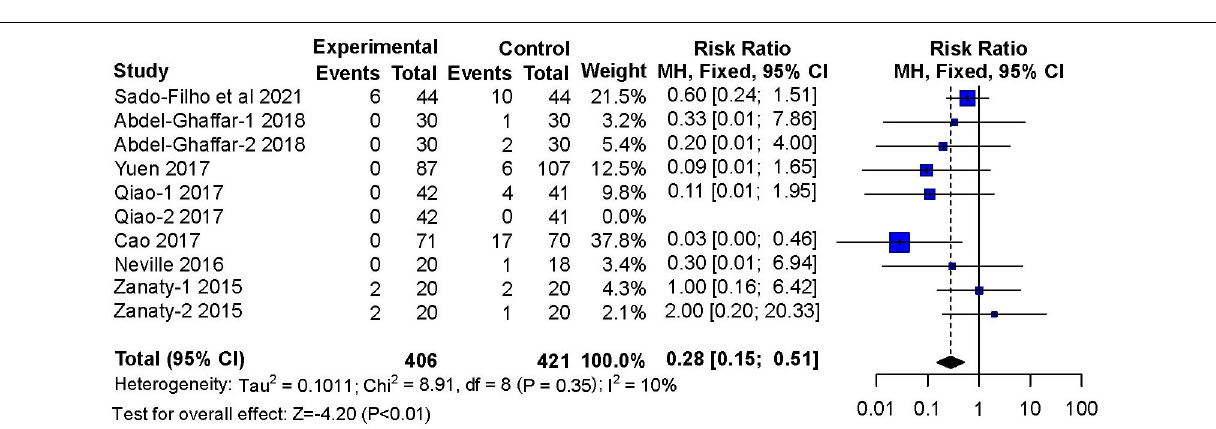
FIGURE 11 | Meta-analysis of nebulized dexmedetomidine for postoperative nausea and vomiting. CI, confidence interval; df, degress of freedom; M-H,